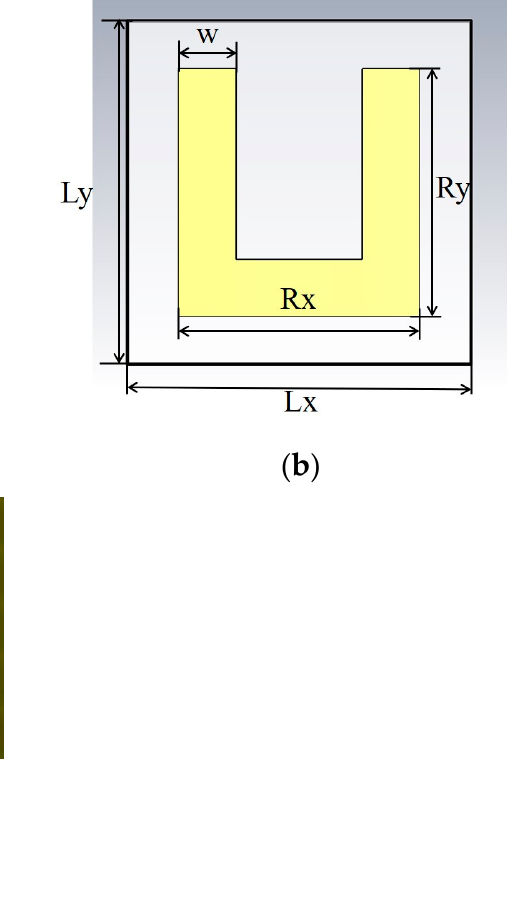
upper right corner contains an image of the red circle area on the QWP, which has been magnified 1000 times.